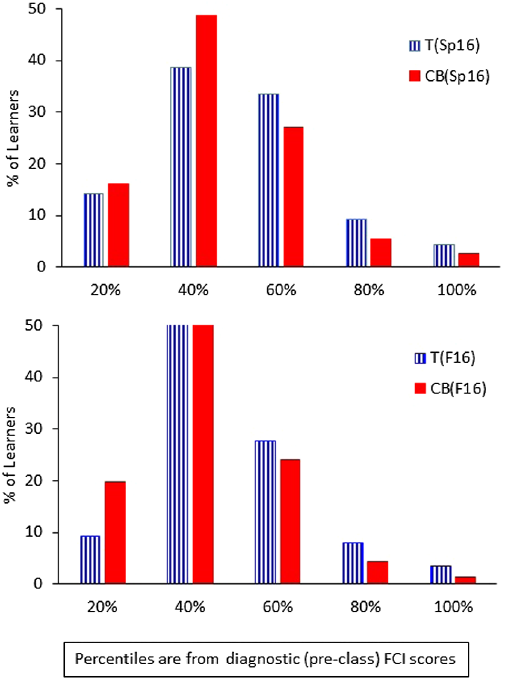
FIG. 3. Distribution of learners of the two classes (Tand CB) in terms of their diagnostic FCI scores at the beginning of spring (top) and fall (bottom) semesters in 2016. The height of the vertical bars indicate the percent learner population that fell into each percentile group listed along the horizontal axis. The striped columns represent the T class and the solid columns represent the CB class. In both classes, 65% to 70% of the learners remained in the below 40% range of the diagnostic FCI